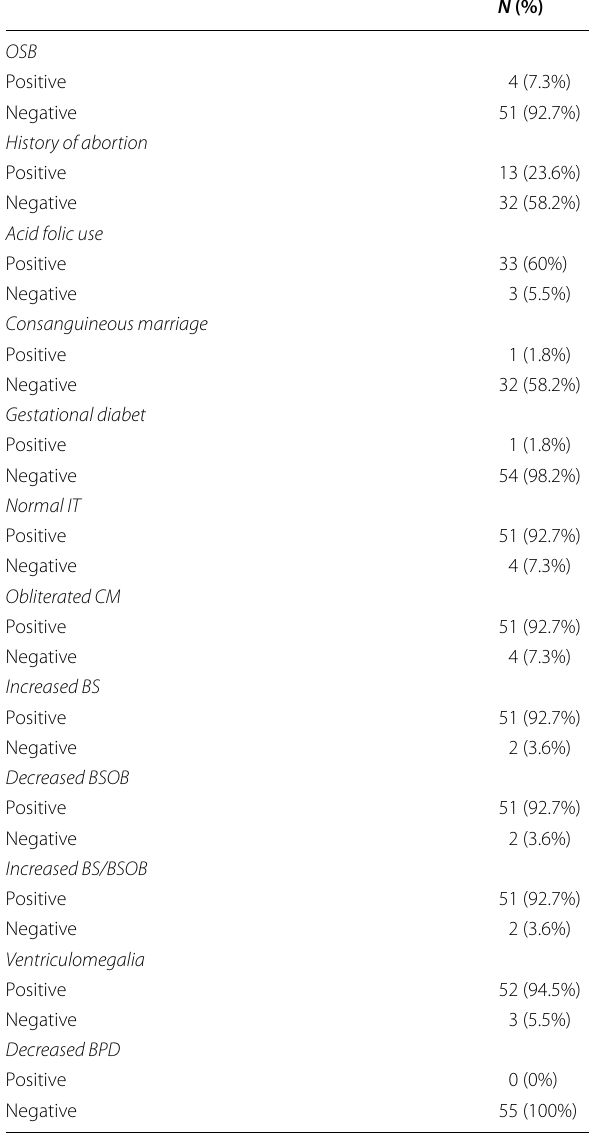
Table 2 Characteristics of patients and sonographic